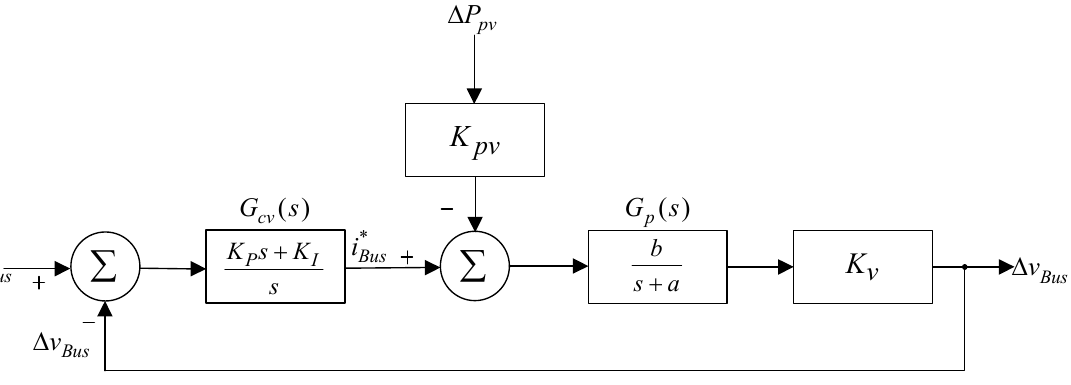
Figure 7. Bode plot of the current loop frequency response for the 10 000